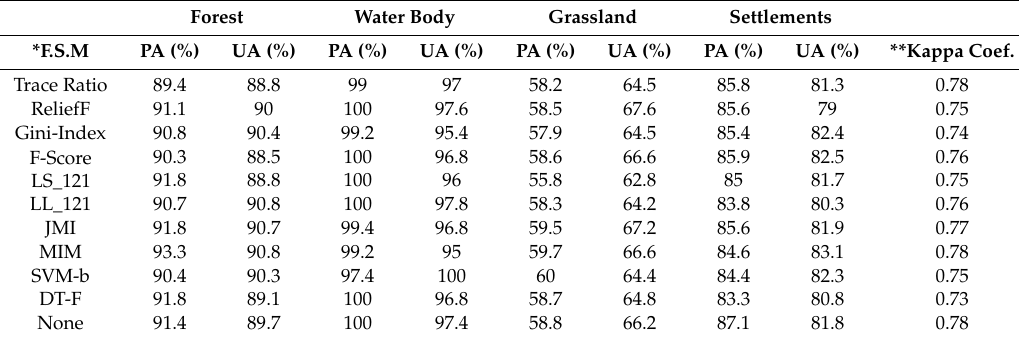
Table 3. Classification accuracies of other classes using optimal feature subsets yielded by investigated feature selection methods for first training set.